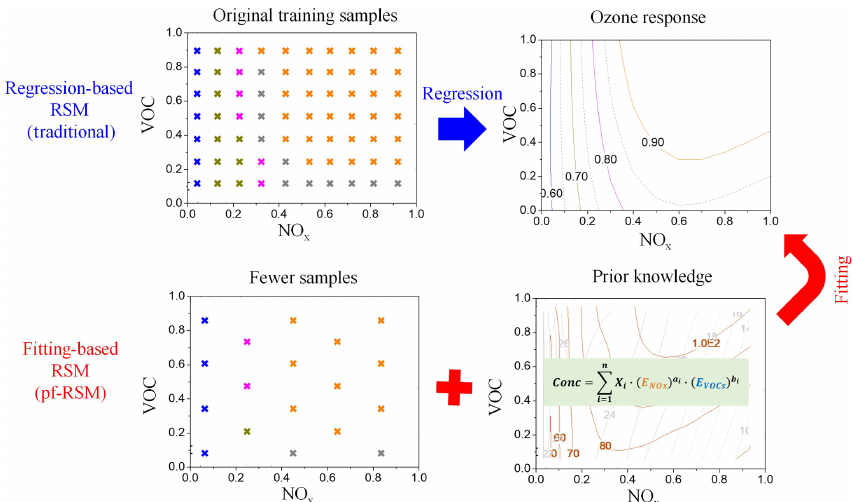
Figure 1. Schematic plot of comparison between the traditional RSM (regression-based) and the RSM with a polynomial function (denoted as “pf-RSM”, fitting-based).